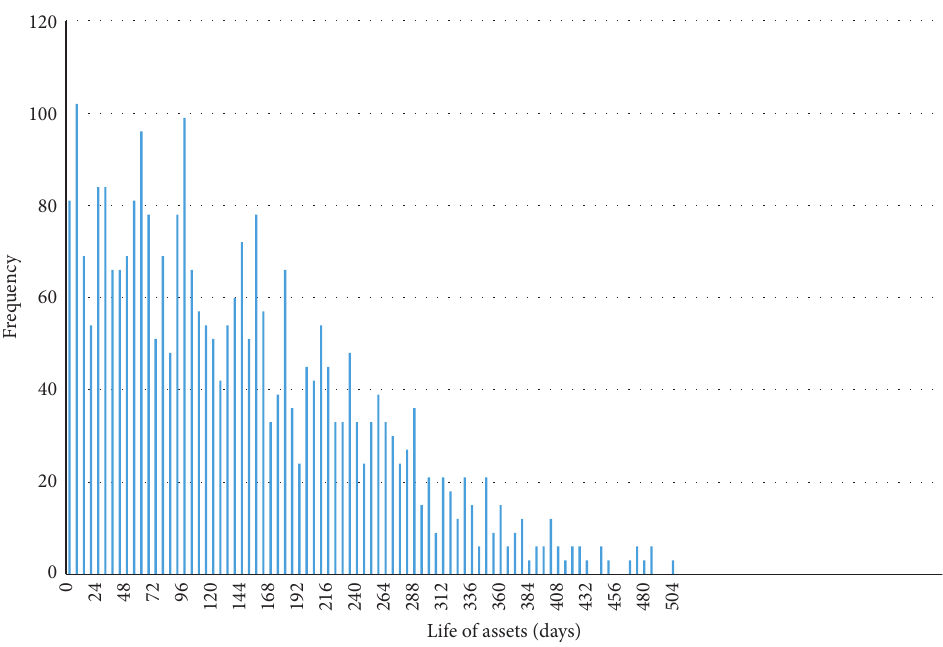
Figure 5: Distributions of assets in the parent pool: life of